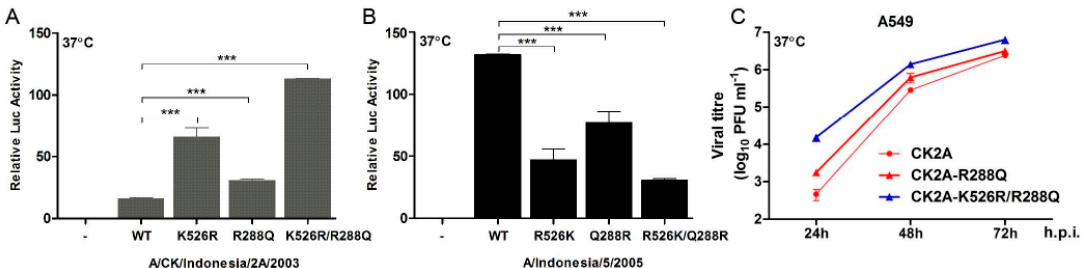
Figure 8. Effect of PB2 R288Q on viral replication and RNP activity in Indonesian H5N1 viruses. R288Q, alone and in combination with K526R, was introduced into the PB2 segment of the H5N1 avian isolate, A/Chicken/Indonesia/2A/2003, and alternatively, the back mutations Q288R and R526K, separately and in combination, were introduced into the PB2 of the H5N1 human isolate, A/Indonesia/5/2005. Plasmids of the minigenome system, consisting of NP, PB1, PA and wild type PB2, or the corresponding PB2 mutants derived from CK2A or IND5, together with a firefly RNP luciferase reporter plasmid and the Renilla luciferase expressing plasmid pRL-TK (as an internal control) were transfected into HEK293T cells. ( A ) Effect of R288Q, alone or in conjunction with K526R, on RNP polymerase activity in the background of other RNP proteins from A/Chicken/Indonesia/2A/2003. ( B ) Effect of Q288R, alone or in conjunction with R526K, on RNP polymerase activity, with other RNP proteins derived from A/Indonesia/5/2005. Luciferase activities were measured at 24 h post transfection using a Dual Luciferase Reporter Assay System (Promega). Firefly RNP activity was normalized against Renilla activity. RNP without PB2 was used as a negative control. Data represent mean normalized luciferase activity from three independent experiments. Statistical significance was analyzed by Student’s t -test.